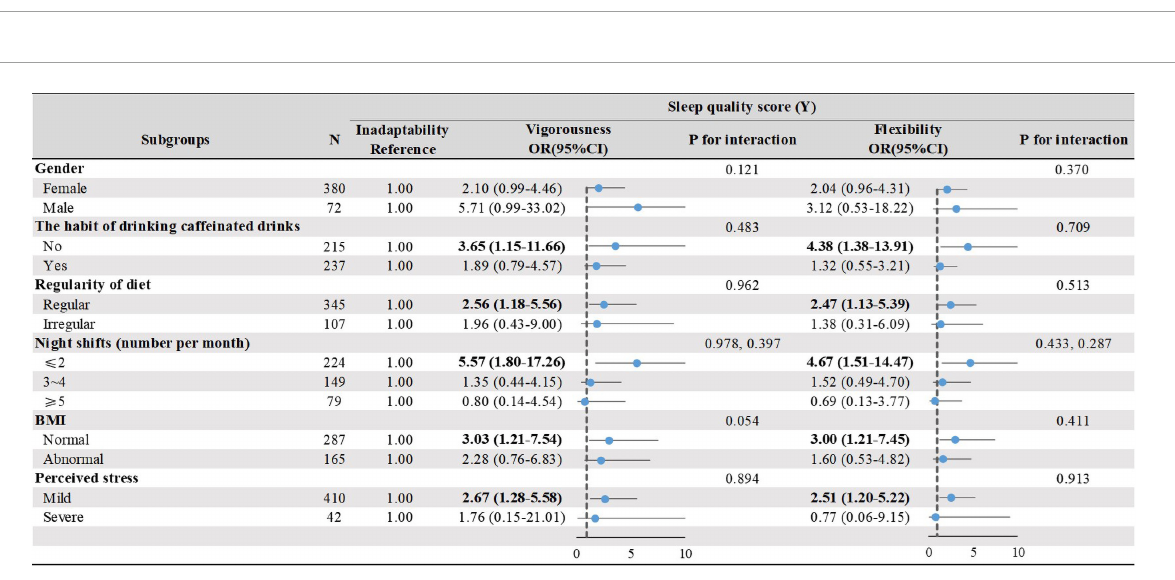
FIGURE5 The effect of circadian rhythm subtypes on sleep quality by stratified analysis. Stratified associations between circadian rhythm types and sleep quality by physiological and environmental factors. Analyses were adjusted for covariates gander, the habit of drinking coffee, regularity of diet, night shifts, BMI, PSS when they were not the strata variables. OR, odds ratio; CI, confidence interval. Bold figures highlight statistically significant in the strata